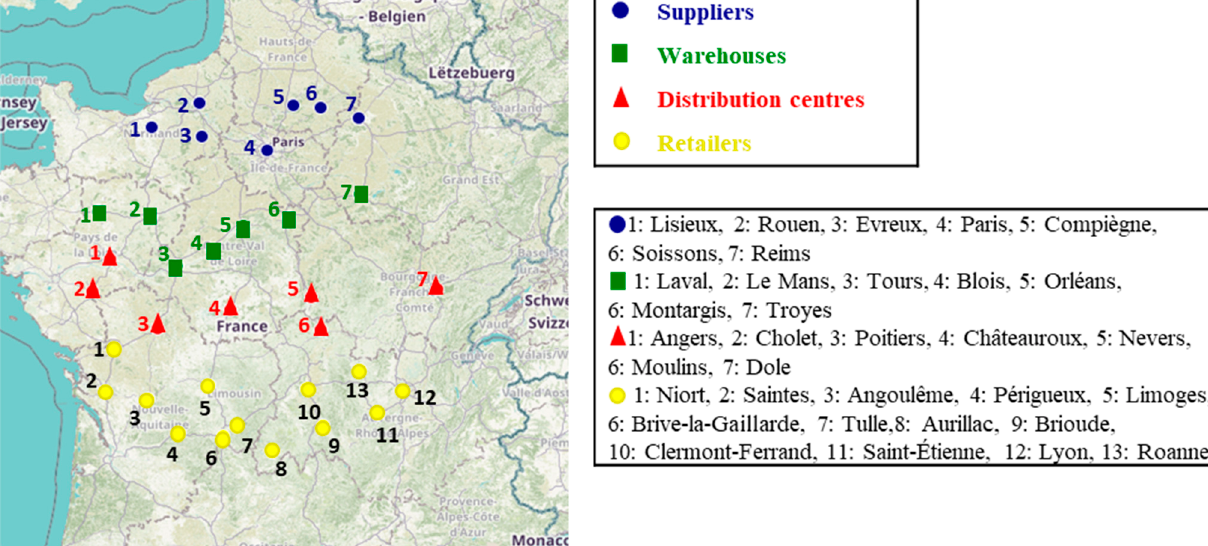
1 Table 4. Other used data.